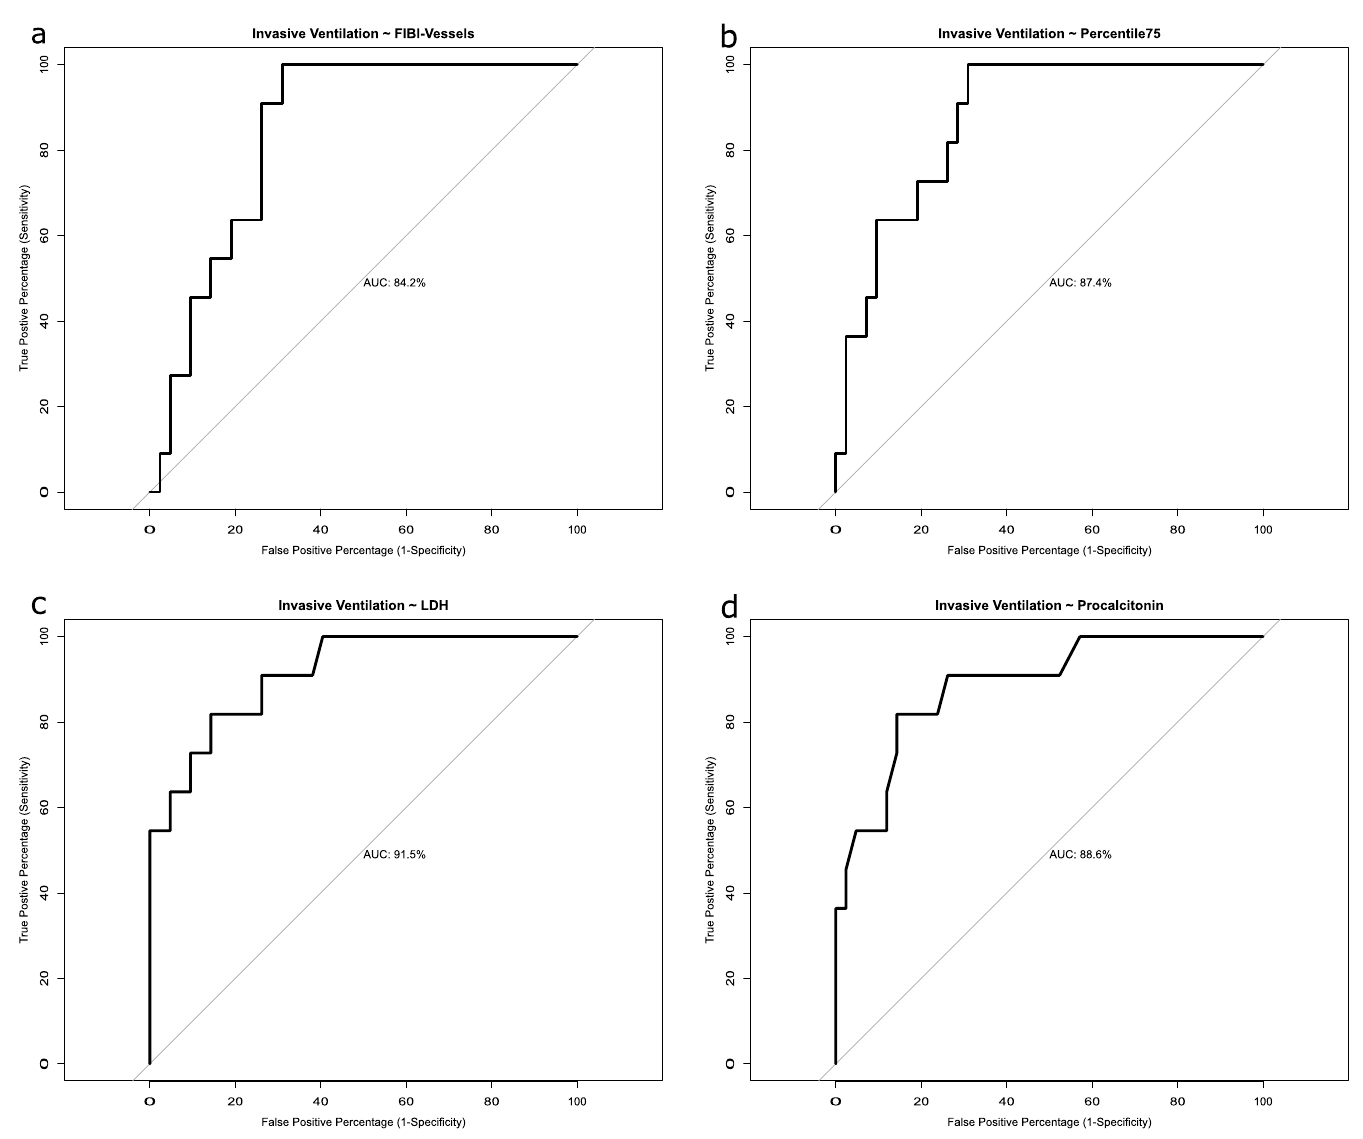
Fig 5. ROC curves of invasive ventilation QCT parameters alone with FIBI -700 (a) vs. 75 th percentile lung density (b) vs. LDH (c) vs. Procalcitonin (d).